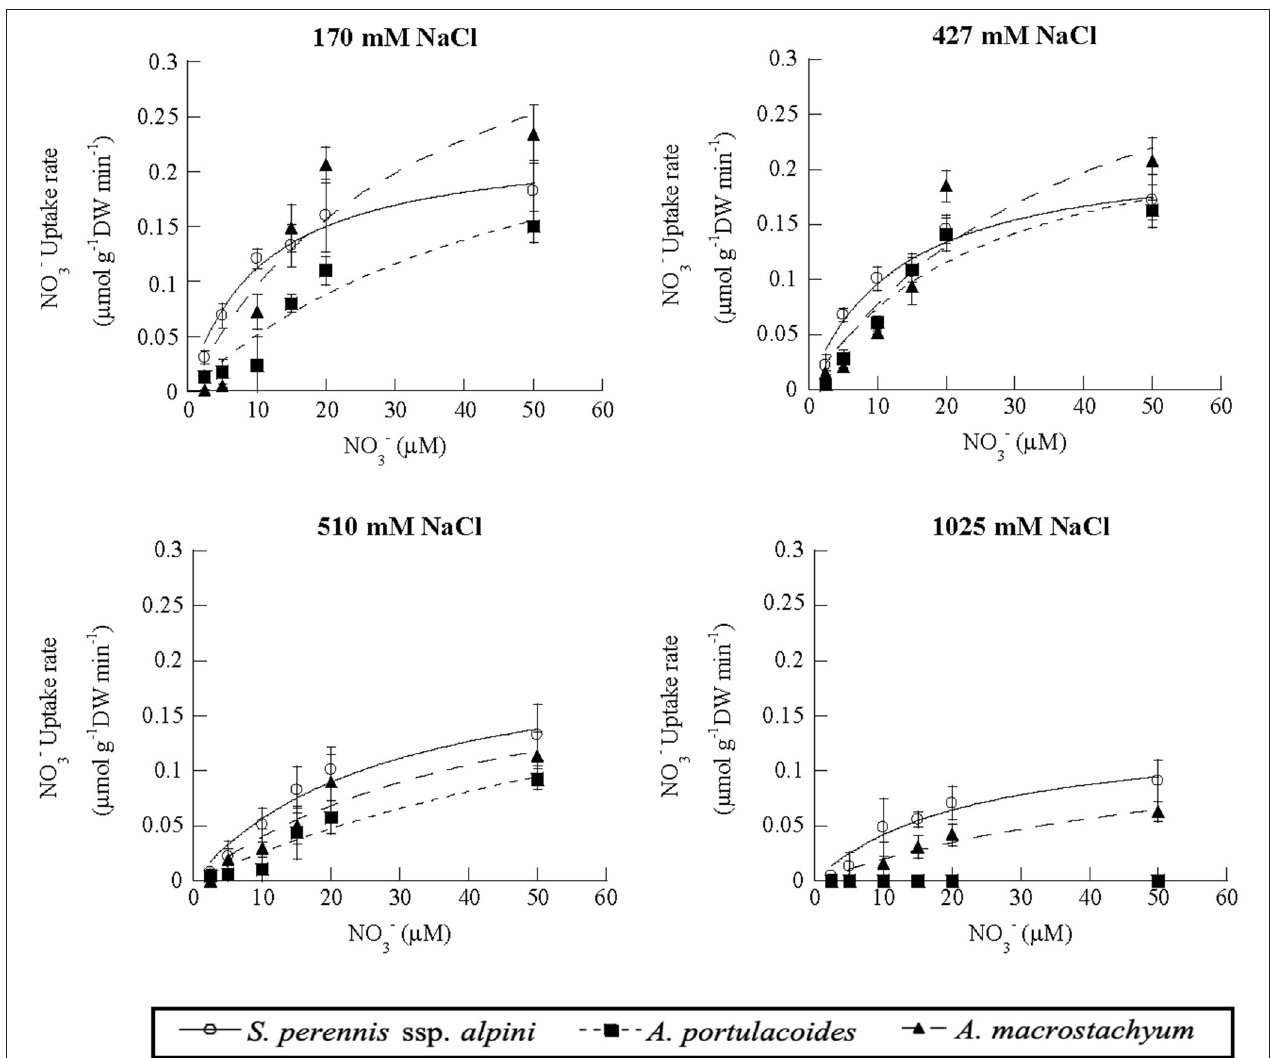
FIGURE 7 | Uptake kinetics of nitrate in S. perennis ssp. alpini, A. portulacoides and A. macrostachyum at different salinities (170, 427, 510, and 1,025mM NaCl). Bars represent standard deviations ( n = 4).